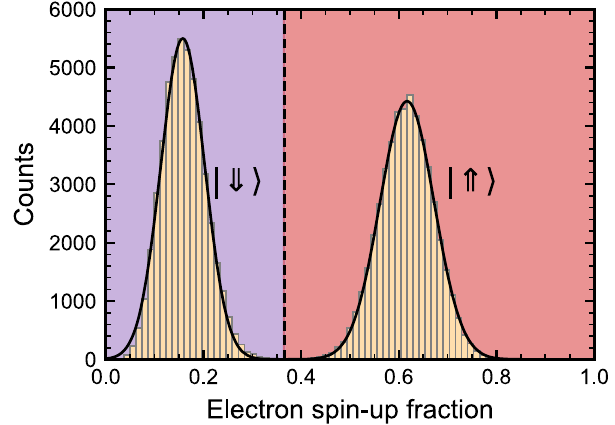
7. Electron j ↑ i fraction recorded throughout experiment from 100 000 nuclear reads which show two clearly resolved